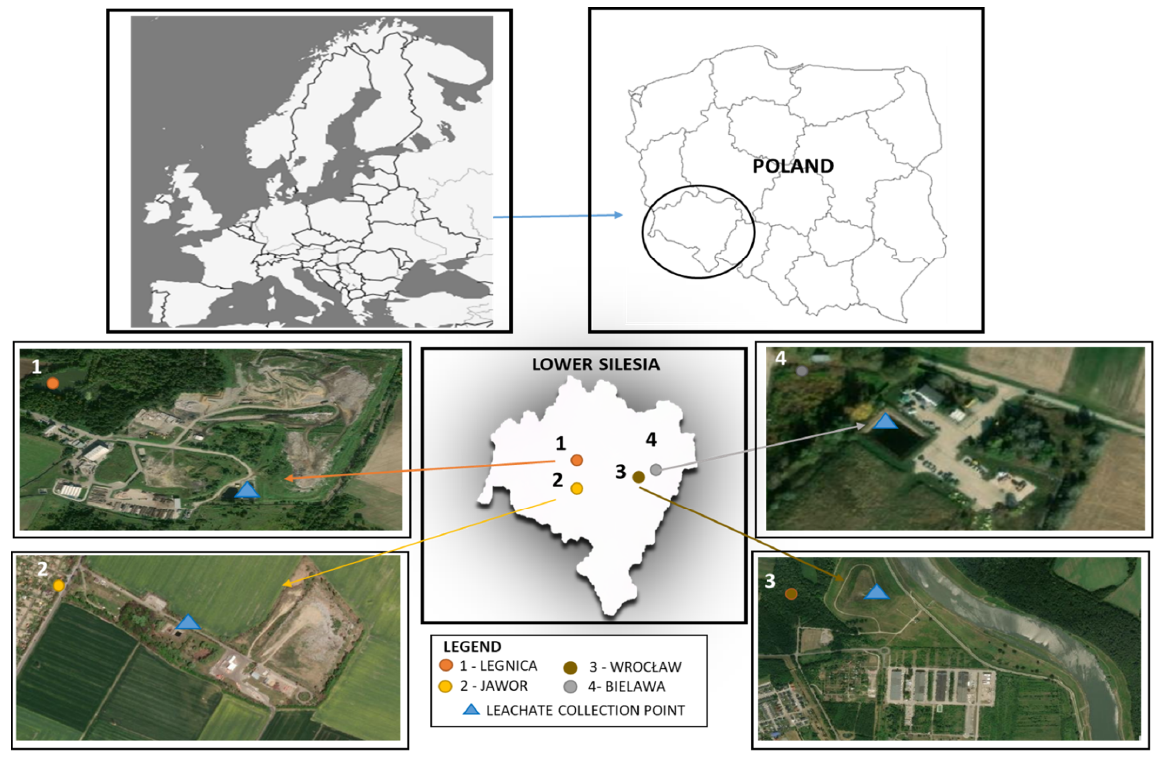
Figure 1. Location of landfills and distribution of leachate collection points.